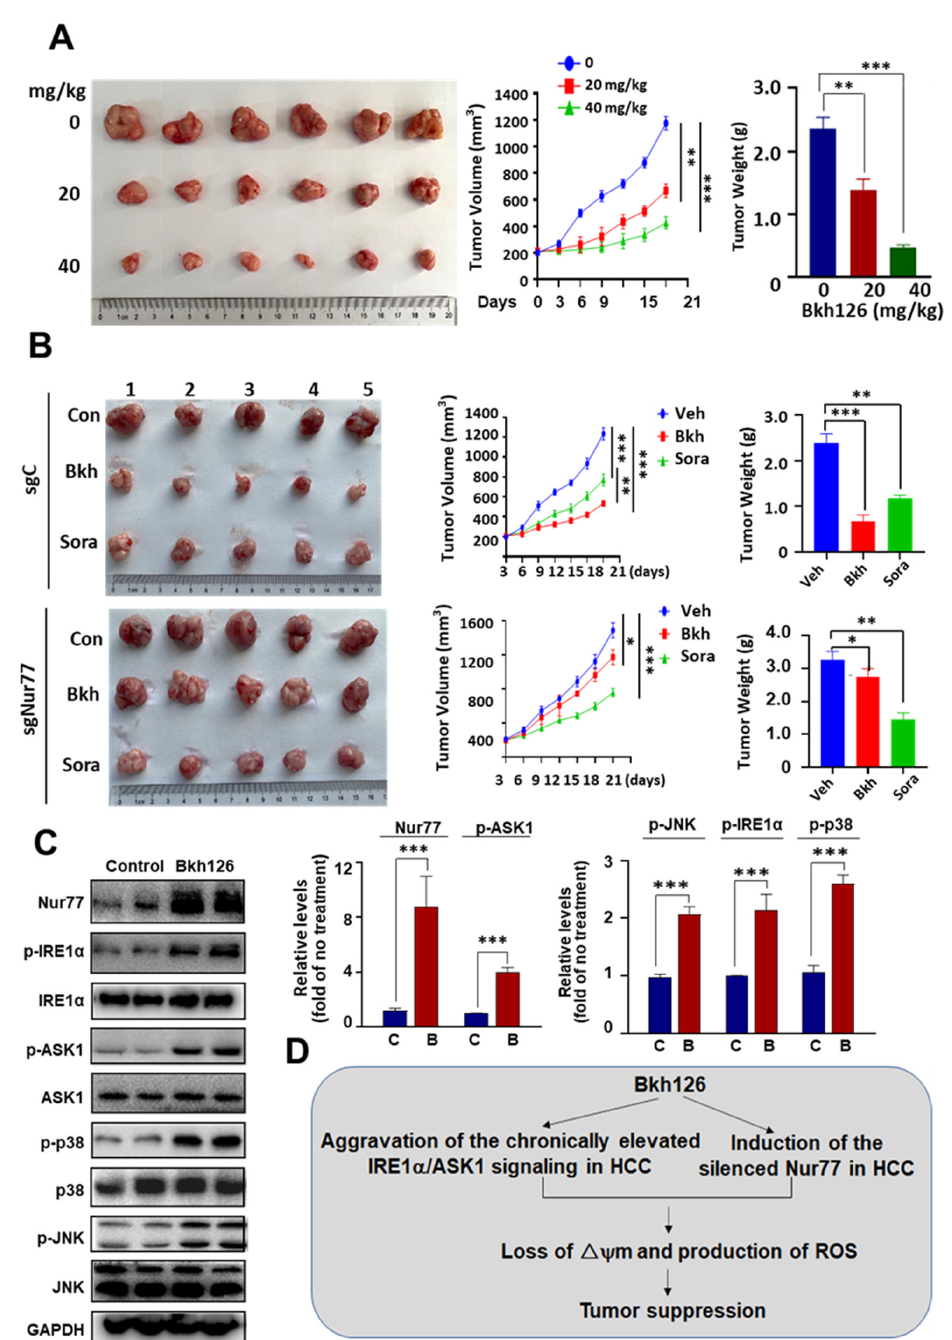
Figure 7. Bkh126 suppresses HCC xenograft tumor growth : ( A ) Male BALB/c nude mice harboring HepG2 xenograft tumors were treated with vehicle or Bkh126 (20 or 40 mg/kg) intraperitoneally once daily for 3 weeks (n = 6 per group). ( B ) Male BALB/c nude mice harboring HepG2 or HepG2(sgNur77) xenografts were intraperitoneally treated with vehicle, Bkh126 (30 mg/kg), or sorafenib (30 mg/kg) intraperitoneally once daily for 3 weeks (n = 5 per group). In ( A , B ), tumor volume was measured with a caliper every three days. The tumors were photographed and weighted. ( C ) Nur77 induction by Bkh126 was determined. The expression and phosphorylation of ASK1, JNK, and p38 were compared between vehicle and Bkh126 treatment (20 mg/kg). ( D ) Mechanistic scheme. * p < 0.05, ** p < 0.01, and *** p < 0.001. C, control; B, Bkh126.